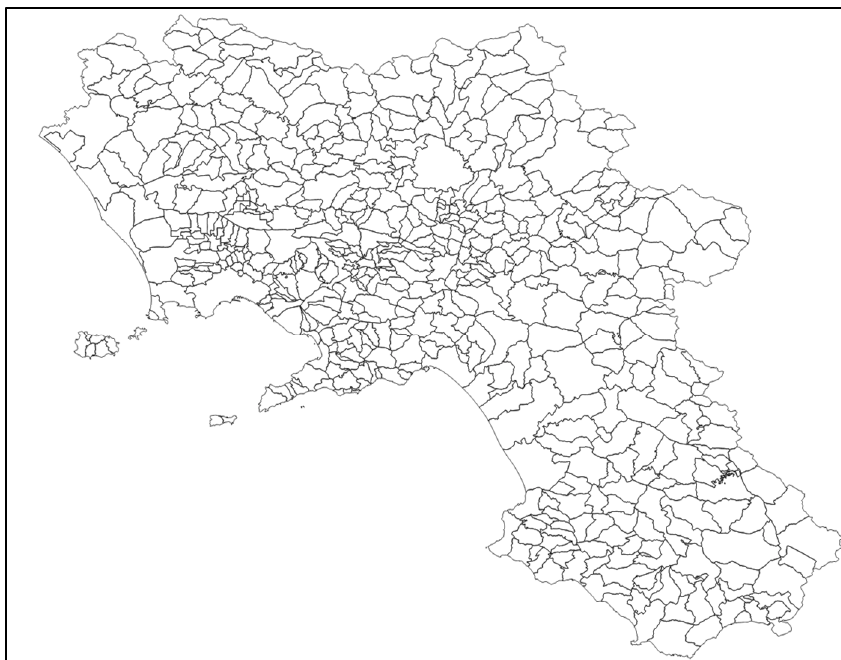
Figure 9. Study area and zoning (regional model).